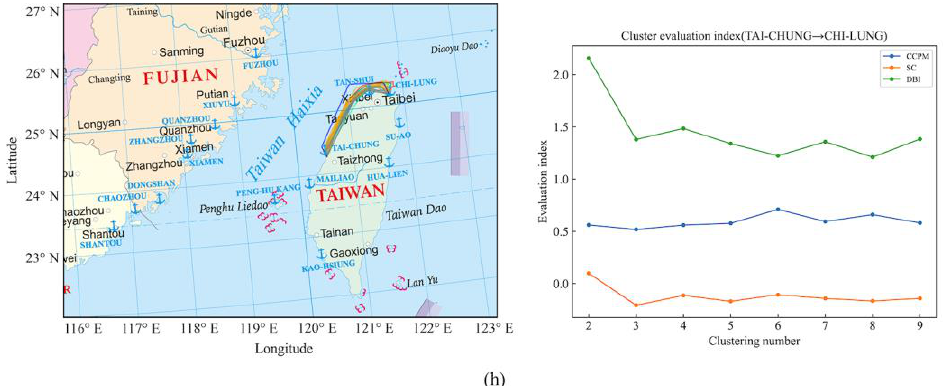
Figure 9. ( a ) Clustering results of ship trajectories from Kaohsiung Port to Fuzhou Port, and four groups of ship trajectory clusters were obtained. ( b ) Clustering results of ship trajectories from Kaohsiung Port to Xiamen Port, and three groups of ship trajectory clusters were obtained. ( c ) Clustering results of ship trajectories from Xiamen Port to Kaohsiung Port, and two groups of ship trajectory clusters were obtained. ( d ) Clustering results of ship trajectories from Taichung Port to Kaohsiung Port, and two groups of ship trajectory clusters were obtained. ( e ) Clustering results of ship trajectories from Fuzhou Port to Xiamen Port, and nine groups of ship trajectory clusters were obtained. ( f ) Clustering results of ship trajectories from Taoyuan Port to Kaohsiung Port, and nine groups of ship trajectory clusters were obtained. ( g ) Clustering results of ship trajectories from Keelung Port to Kaohsiung Port, and eight groups of ship trajectory clusters were obtained. ( h ) Clustering results of ship trajectories from Taichung Port to Keelung Port, and six groups of ship trajectory clusters were obtained.